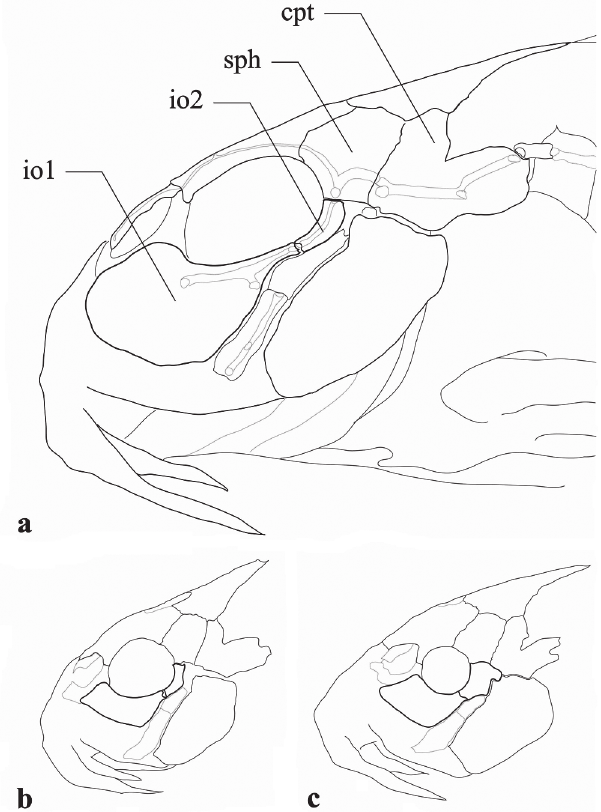
Fig. 2. Schematic drawing of the head of ( a )